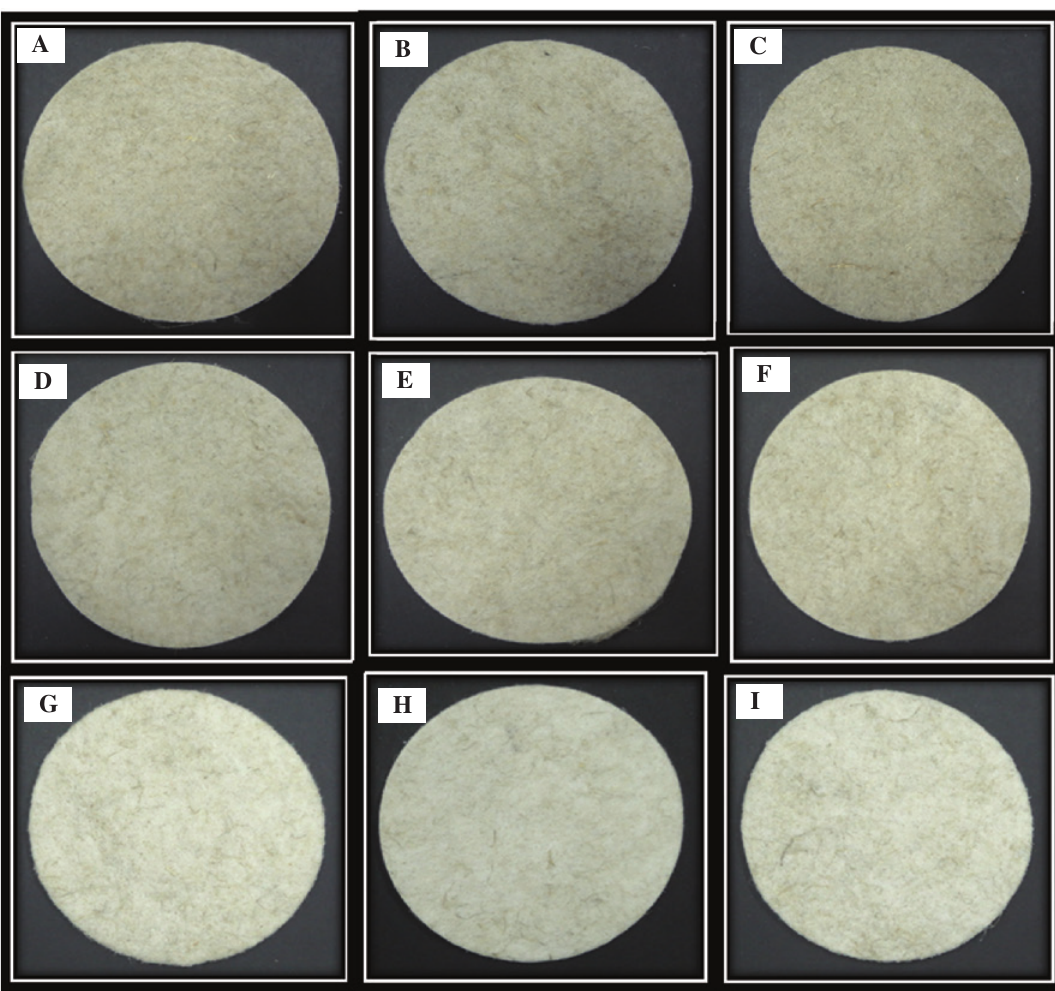
Figure 2: Photographs of the prepared samples with varying proportions of pp in